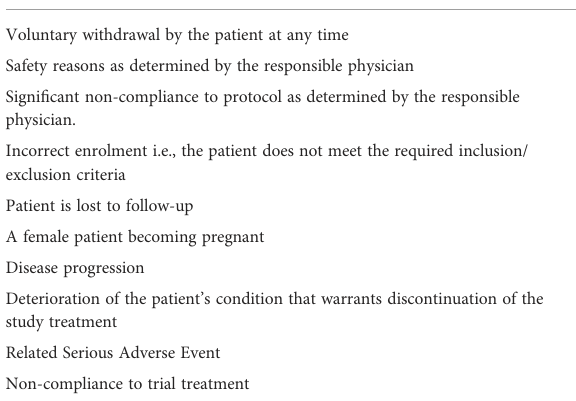
TABLE 5 Withdrawal criteria for the T-RAD